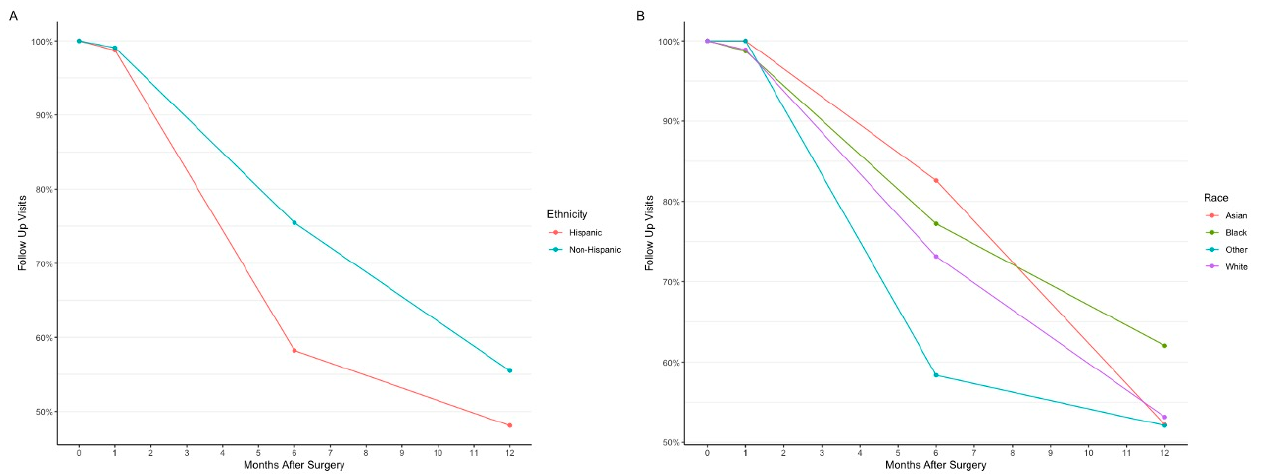
Figure 4. Comparison of follow-up visits by ( A ) ethnicity (Hispanic or non-Hispanic) and ( B ) race (Asian, Black, White, or Other). The four time points indicated are the preoperative visit (month 0), 1-month postoperative visit, 6-month postoperative visit, and 12-month postoperative